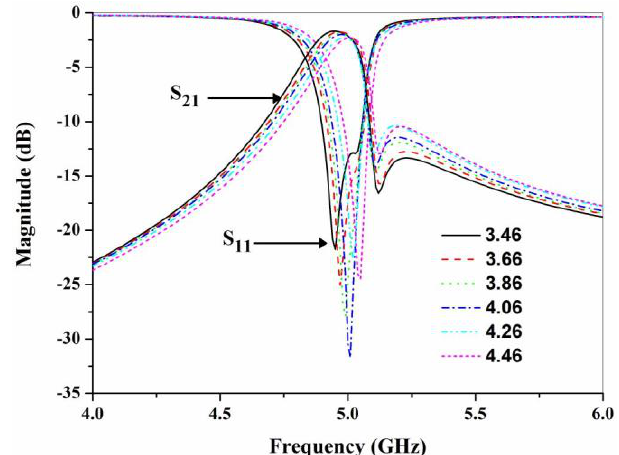
Figure 7: Simulation results for various positions (slot_pos) of horizontal slot for a slot length (slot_hor) of 5.8 mm.